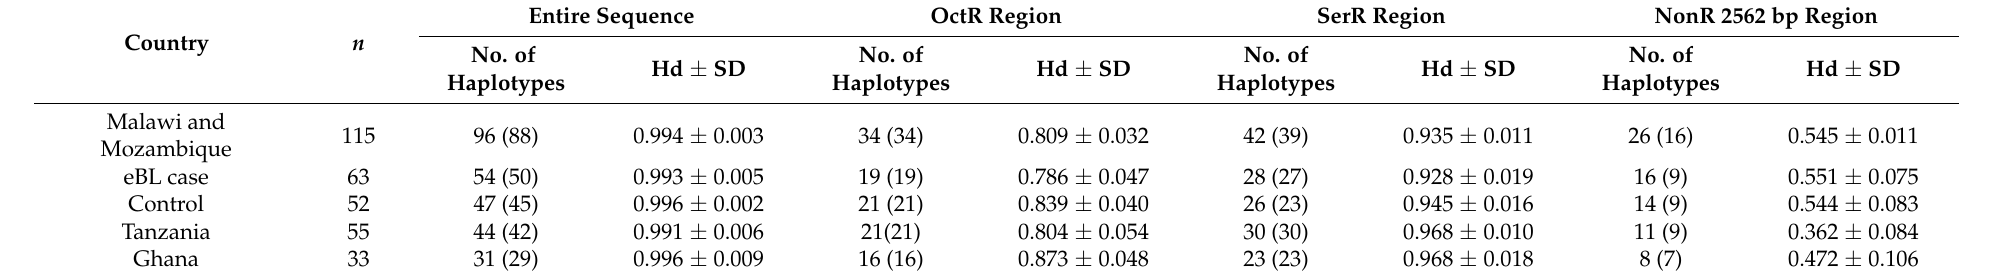
Table 2. Haplotype diversity of the entire sequence, and the octamer repeat (OctR), serine repeat (SerR), and non-repeat (NonR) 2562 base pair (bp) regions of the P. falciparum SERA5 gene. Entire Sequence OctR Region SerR Region NonR 2562 bp Region Country n No. of No. of No. of No. of Hd ± SD Hd ± SD Hd ± SD Hd ± SD Haplotypes Haplotypes Haplotypes Haplotypes 115